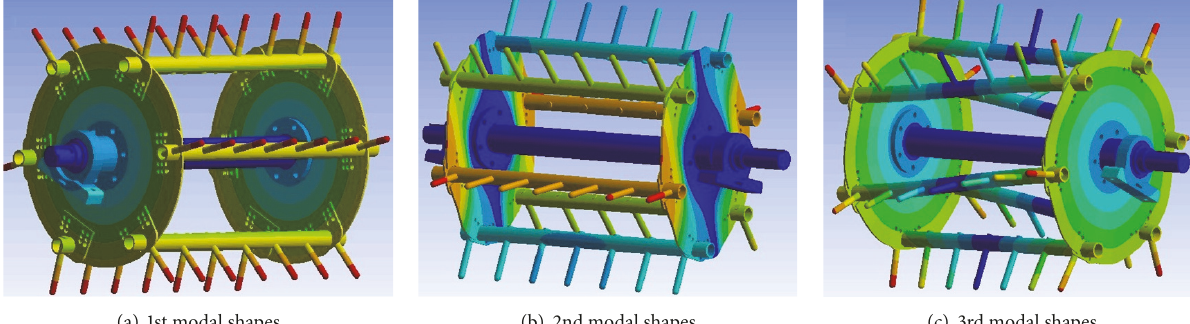
Figure 8: Modal shapes under restricted modality.